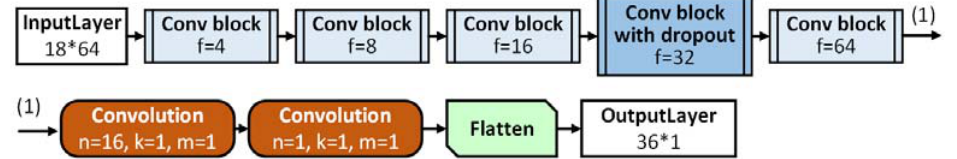
Figure 4. Structure of the VGG-like NN. Note the usage of kernels with size 1 × 3 and 26 of several consecutive convolutions with the same specifics before pooling.